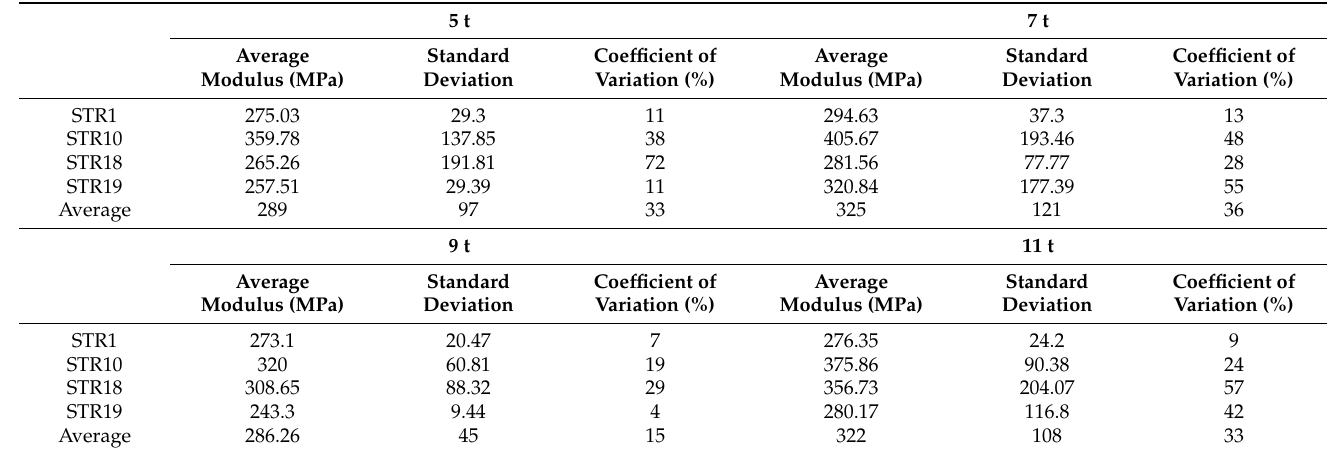
Table 7. The modulus back calculation results of middle